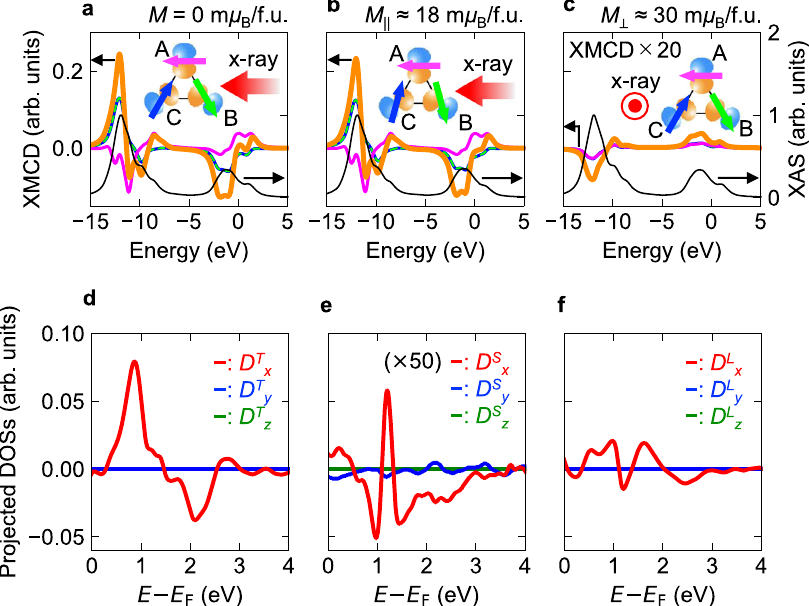
Fig. 4 Calculated XMCD spectra and density of states. a – c The XMCD and XAS spectra were obtained by the model calculation for different magnetic structures and X-ray con fi gurations shown in the insets. For Mn 3 Sn, x 2 – y 2 type orbit is predicted to be the ground state for minority spins from our fi rst- principles calculation as shown in the insets. The orbital arrangement obtained from the fi rst-principles calculation is used in the atomic model calculation for XAS and XMCD. The individual XMCD response from each sublattice A, B, and C is indicated by magenta, dashed light green, and blue curves, respectively. The total sum of the XMCD spectrum is shown by the bold orange line. In a , the magnetic moments are completely canceled, while the magnetic moments on sublattice B and C in b are slightly tilted toward the X-ray direction to reproduce the situation with in-plane external fi eld of ~1 T (the tilted angles are exaggeratingly illustrated in the inset). In c , the X-ray direction is perpendicular to the plane, and magnetic moments are also slightly tilted to the out-of-plane direction (the corresponding perpendicular applied fi eld is ~1.6 T). d – f Projected components of DOSs for T moment ( D T ), S ( D S ), and L ( D L ) (left to right) were obtained from the fi rst-principle calculations. In e , the value of D S is 50 times magni fi ed. The magnitude of D T x is much larger than those of D S x and D L x ( M ⊥ ≈ 30 m μ B /f.u., the corresponding perpendicular applied fi eld sublattice B and C in Fig. 4b is slightly tilted to the X-ray is ~1.6 T). The XMCD spectra of each sublattice are also shown in directions to reproduce the situation with in-plane external the fi gure: the individual XMCD contributions from sublattice A, magnetic fi eld of ~1 T ( M || ≈ 18 m μ B /f.u.). In Fig. 4c, the direction B, and C are illustrated by magenta, dashed light green, and blue lines. In the calculation for Fig. 4a, the Mn spin moments are of incident X-ray is perpendicular to the plane, and magnetic perfectly compensated, so that the spin contribution for XMCD is moments are slightly tilted towards out-of-plane direction